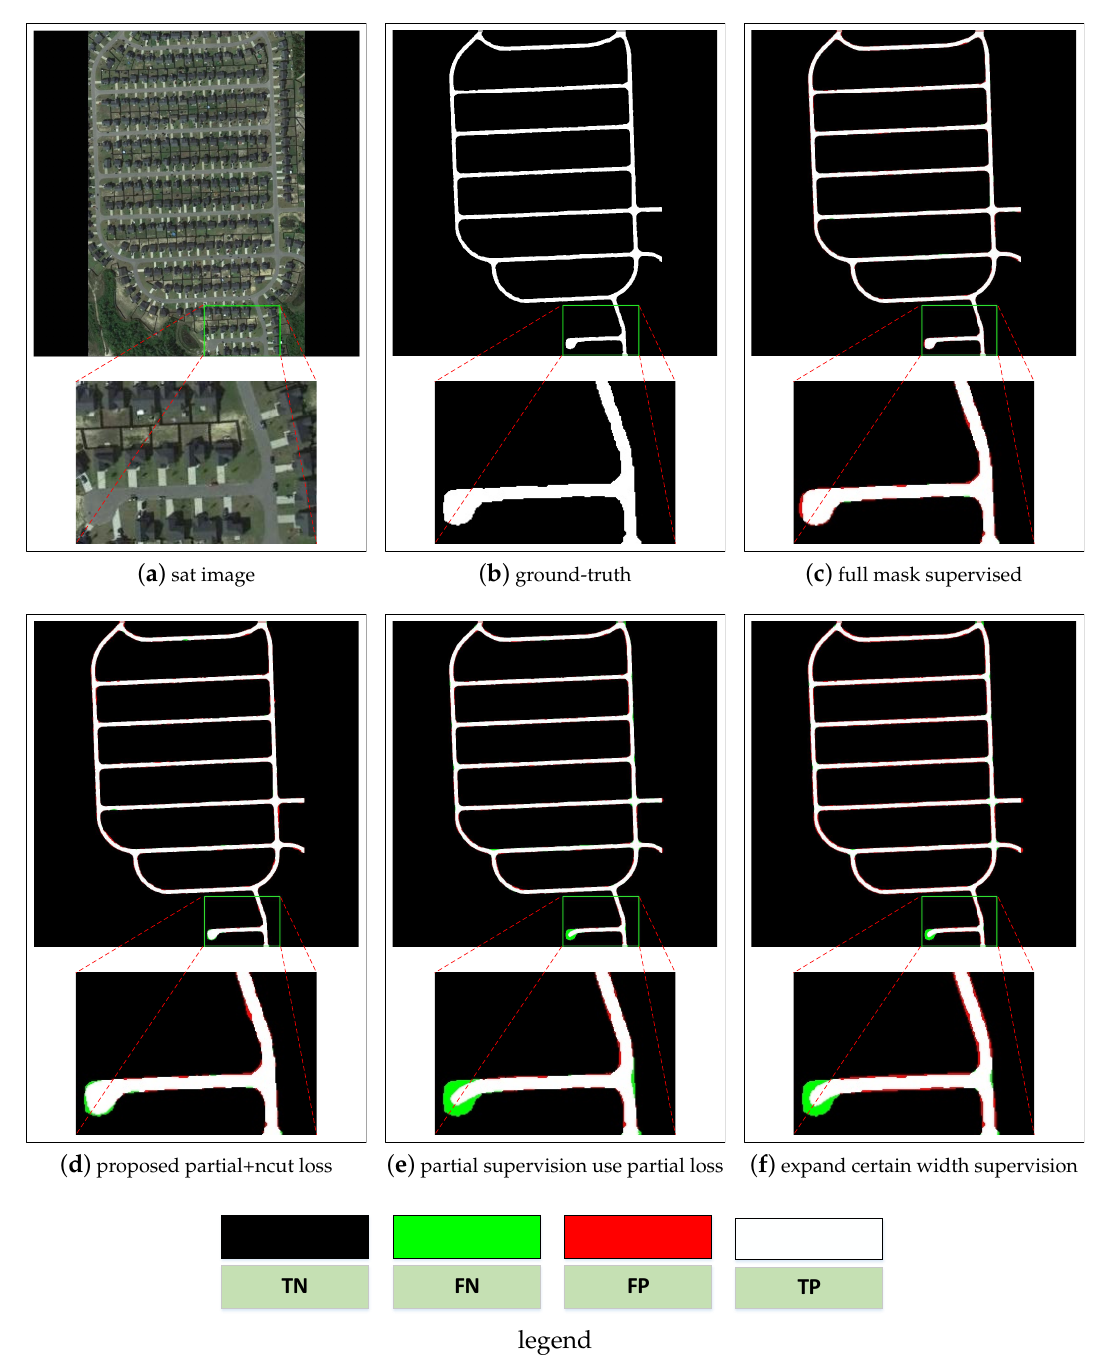
Figure 5. A sample for results with different methods on dataset 1. ( a ) The satellite; ( b ) the pixel-wise ground truth; ( c ) the extracting road using full supervised MD-ResUNet; ( d ) use of the partial loss combined with normalized cut loss; ( e ) use of the partial loss function; and ( f ) supervised by the expand data. TN = true negative; FN = false negative; FP = false positive; TP = true